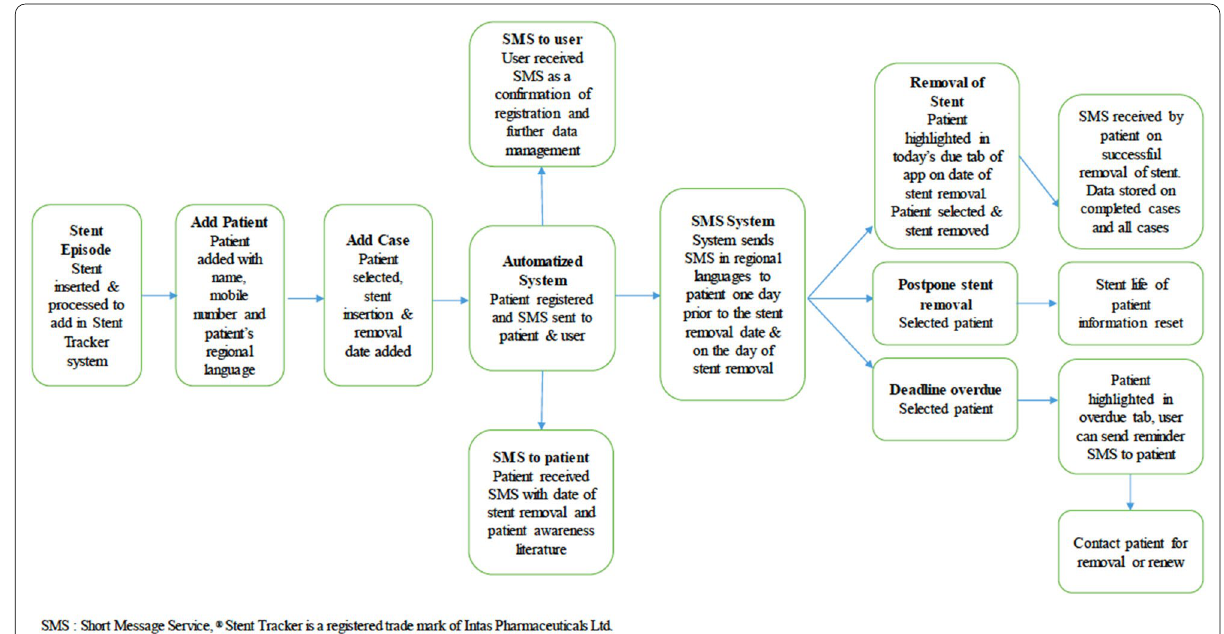
Fig. 5 Flowchart for stent Tracker ®